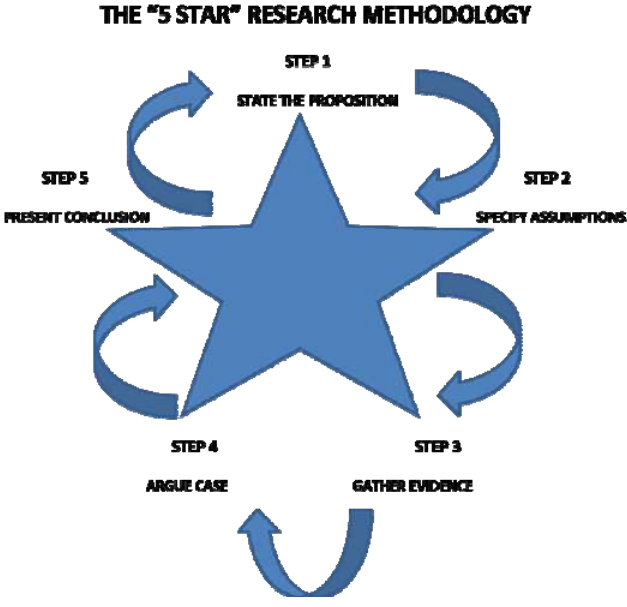
Fig. 1. “5 Star” research